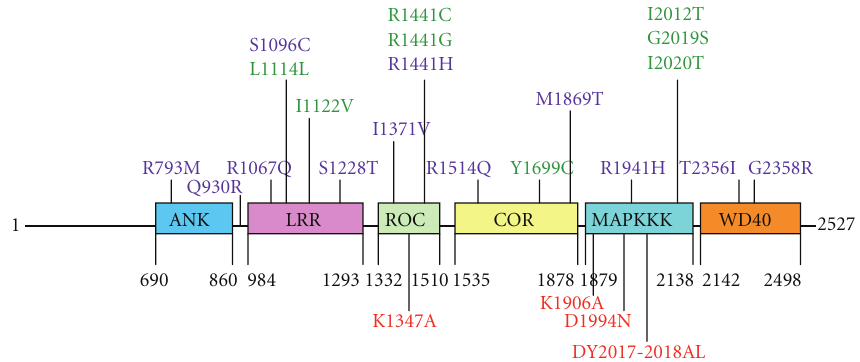
Figure 1: LRRK2 domain structure and PD-linked point mutations . The predicted domain boundaries are indicated by the residue numbers beneath. The position of the putatively pathogenic amino acid substitutions are shown in purple. Substitutions segregating with PD are shown in green. The kinase null and no-GTP binding alterations are shown in